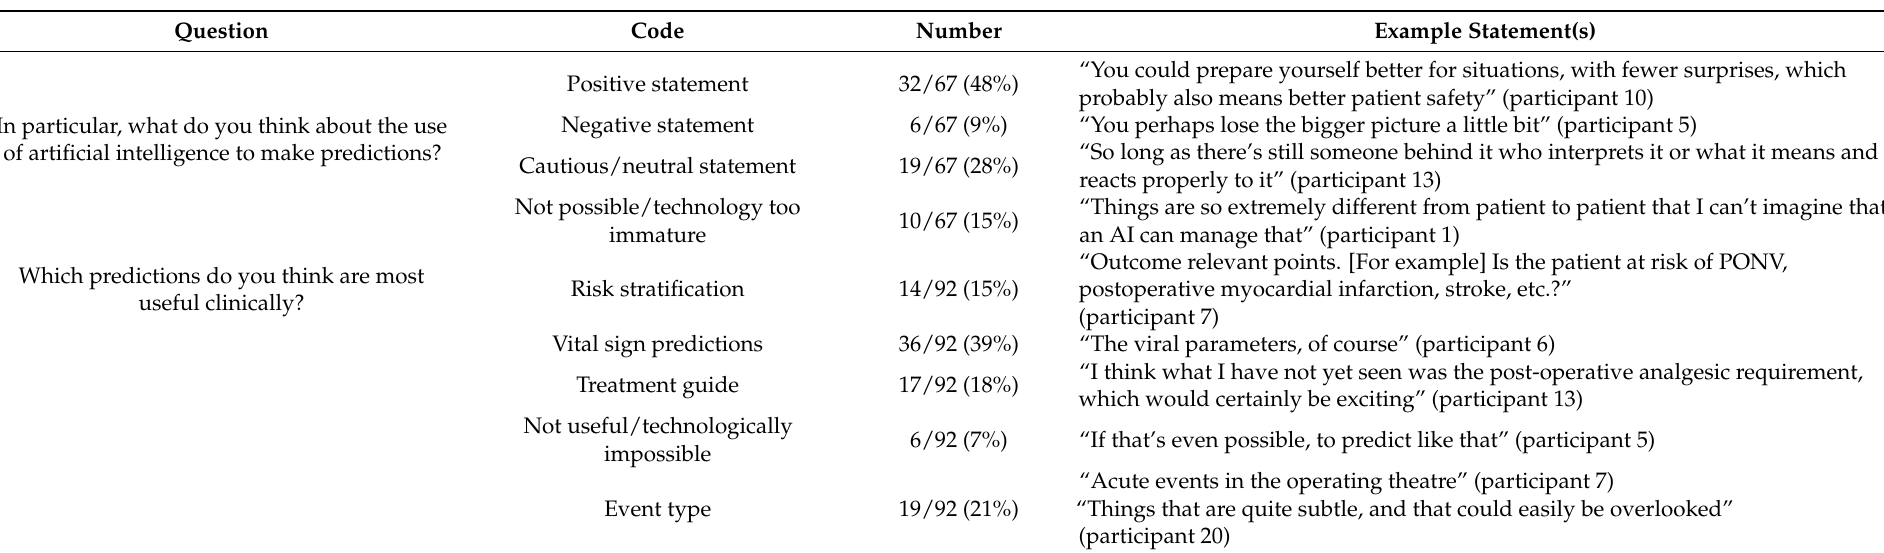
Table 4. An overview of responses to questions 4 and 5, demonstrating a positive view of the use of AI to predict important clinical events, with example statements. Values are number